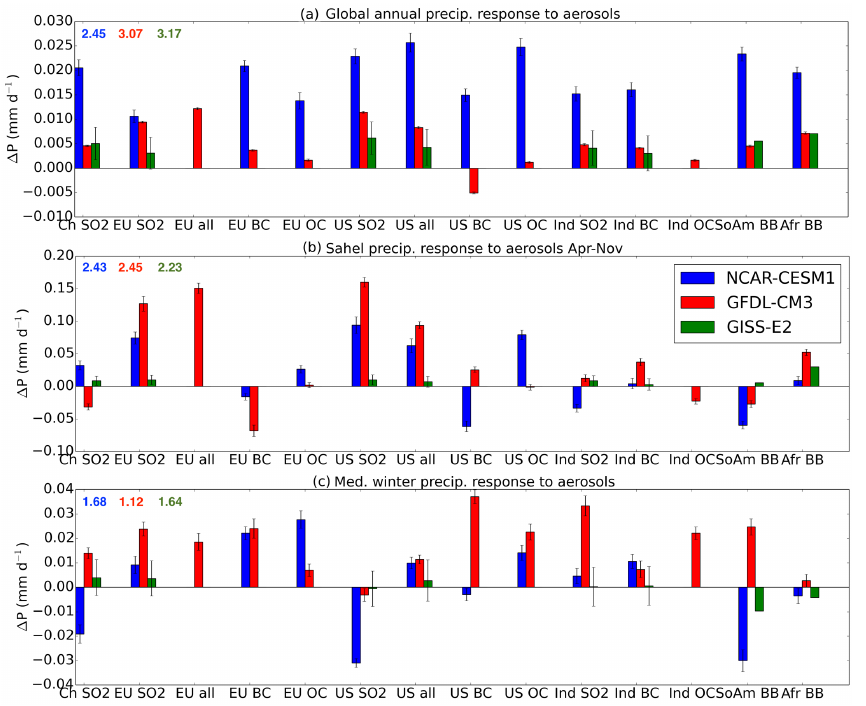
Figure 2. Regional and global precipitation response to each individual aerosol emissions decrease (Table 1). (a) Global annual, (b) Sahel for June–September, (c) Mediterranean for October–March. Error bars represent ± 1 σ . Values in the upper left of each panel are control mean precipitation values for each region and time period for each model (green: GISS-E2, red: GFDL-CM3, blue: CESM1).